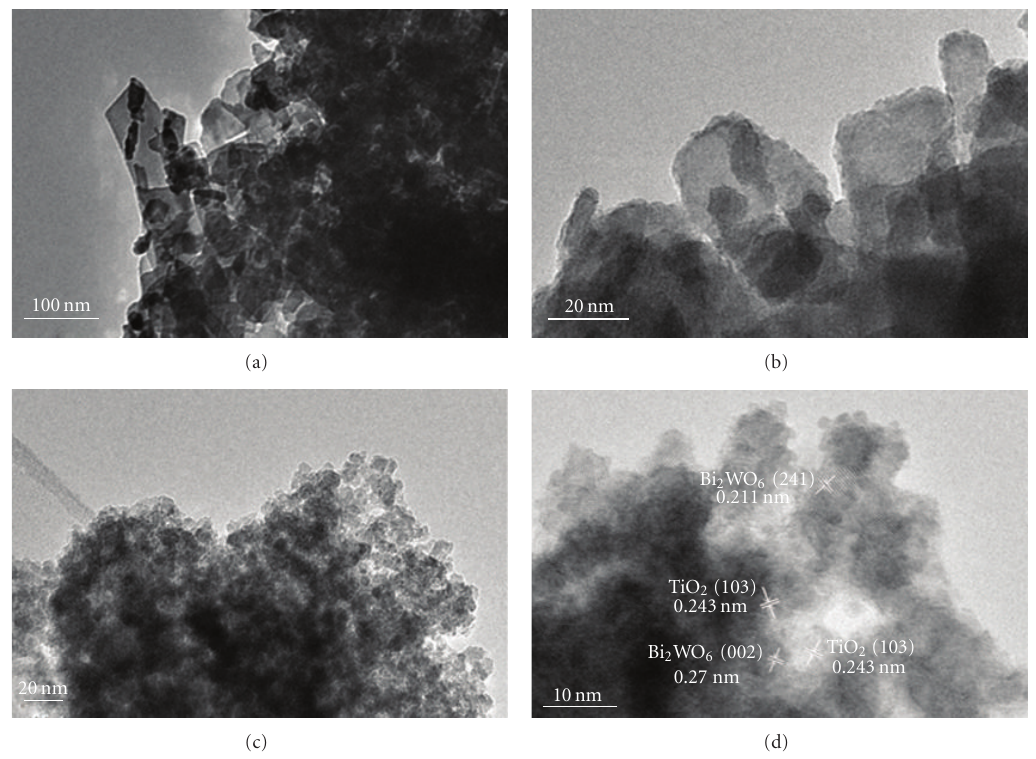
Figure 3: TEM photographs for the as-prepared N-BWO (a, b) and TiO 2 /N-BWO (c,